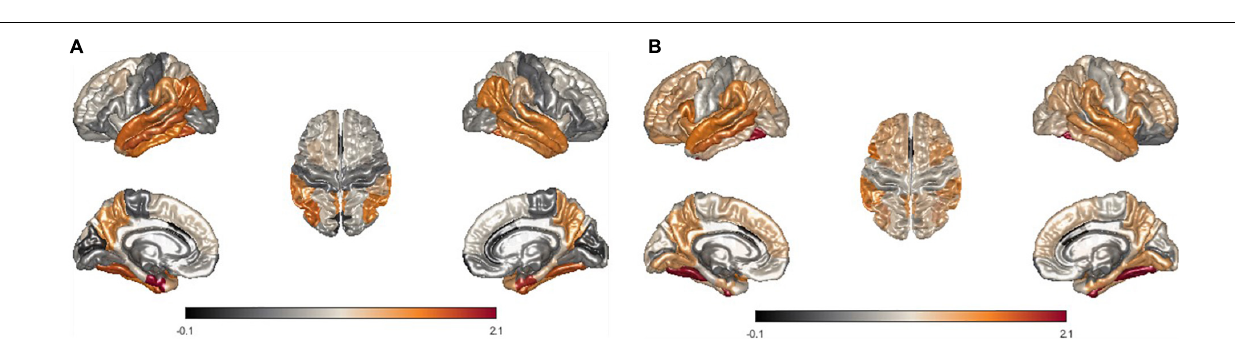
FIGURE 5 | Visualization of mean LME-W over each patient with neurodegenerative disease. Since the w-score represents the atrophy of each region, LME-W identifies the entorhinal cortex, fusiform gyrus, temporal lobe, and inferior parietal lobe as the Alzheimer’s dementia risk area (A) . Similarly, fusiform gyrus, precuneus, supramarginal gyrus, and temporal lobe are identified as the Parkinson’s disease risk area (B)